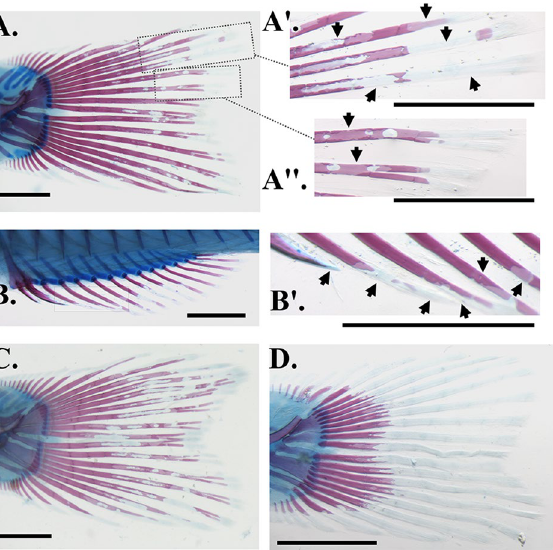
Figure 5. Representative examples of ray-resorption syndrome in seabream samples. ( A ) Caudal fin. ( B ) Anal fin. A ′ –A ′′ and B ′ . Insets of figure ( A ) and ( B ), showing in detail the non-mineralized areas, resembling typical resorption lacunae (arrows). ( C , D ). Examples of different phenotypes of ray-resorption syndrome on seabream caudal fin. Scale bars equal to 1